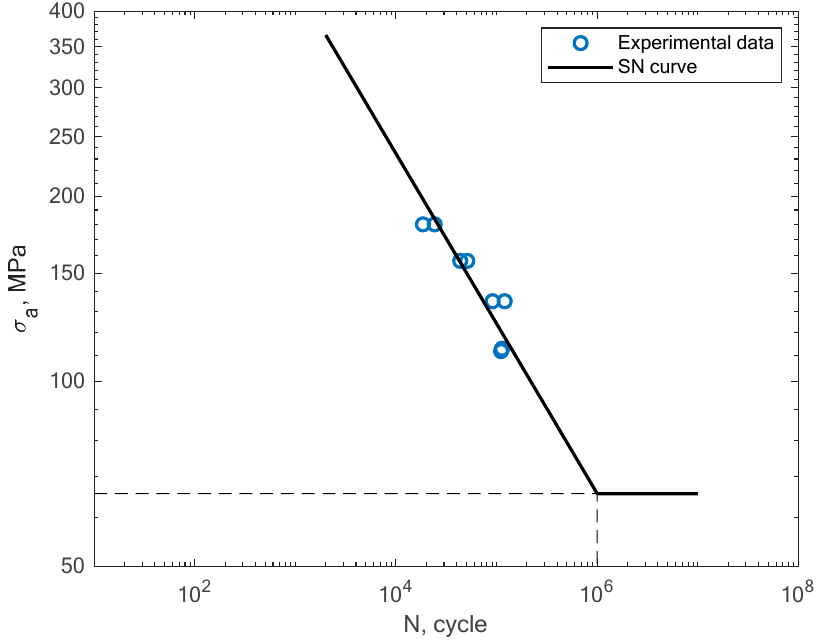
Figure 20. S–N curve for the experimental tension–compression (R = 0.55) fatigue test results reported by Tshabalala et al. [13] for the case of non-zero mean stress.